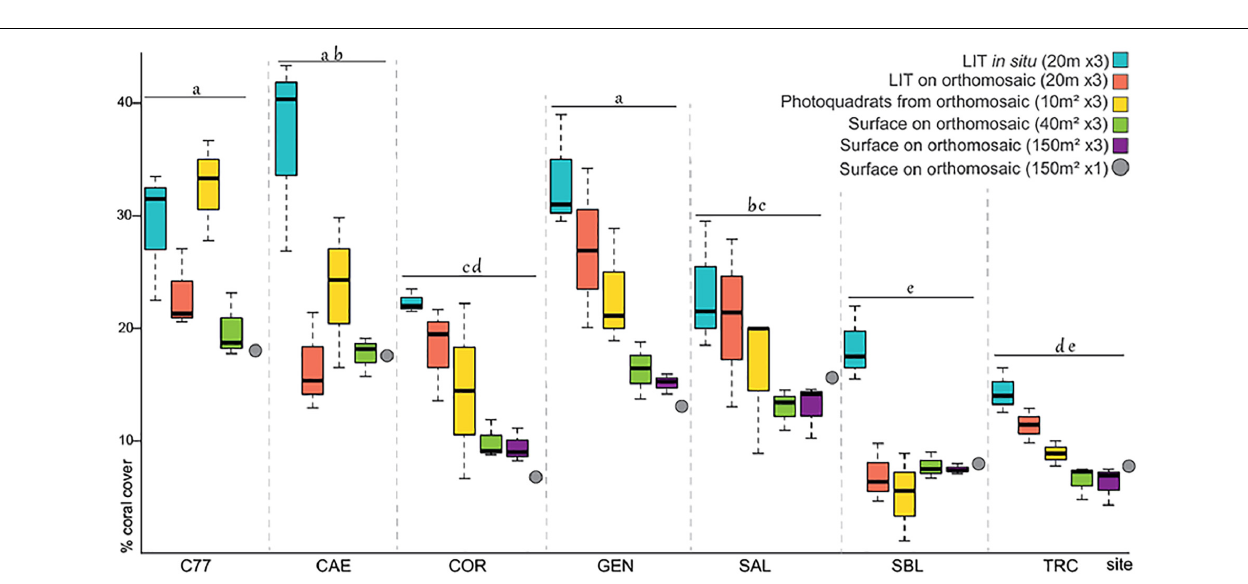
FIGURE 3 | Method x Site interaction plot of percent coral cover estimations. Groups with the same Greek letters ( α , β , γ ) display no significant difference (two-way ANOVA and Tukey tests, p < 0.001). Colors represent survey methods: LIT in-situ (turquoise); LIT from orthomosaic (pink), Photoquadrats from orthomosaic (yellow); surface analyses on orthomosaic sampling 40 m 2 × 3 (green); surface analyses on orthomosaic sampling 150 m 2 × 3 (purple).